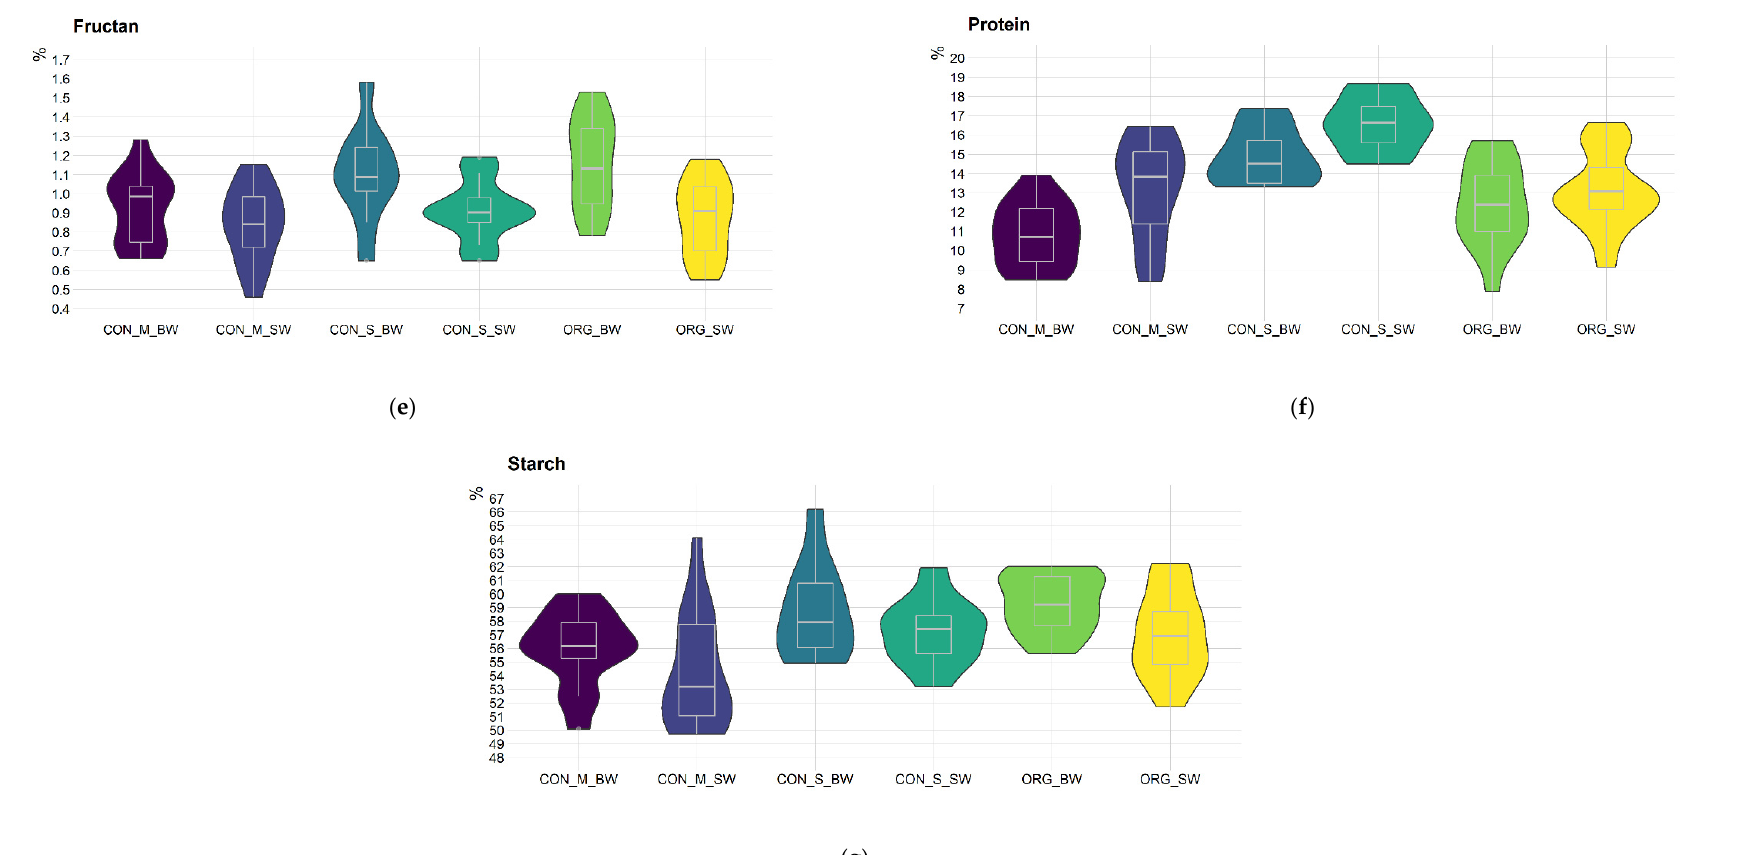
Figure 1. Violin plots for ( a ) Total arabinoxylan, ( b ) Water-extractable arabinoxylan, ( c ) β -glucan, ( d ) Alkylresorcinol, ( e ) Fructan, ( f ) Protein and ( g ) Starch content; CON—conventional farming system; M—Martonvásár, Hungary; S—conventional farming system in Serbia; ORG—organic farming system in Hungary; BW—bread wheat; SW—spelt wheat; minimum value—shown by the line below the violin plot; the first lower quartile (25th percentile)—shown by the lower end of the violin plot; median—shown by the horizontal line inside the plot; the third upper quartile (75th percentile)—shown by the upper end of the plot; maximum value—shown by the line above the violin plot.